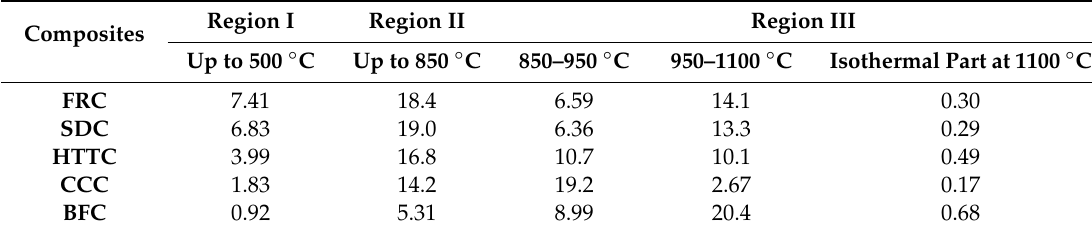
Table 7. Mass loss (wt %) of composites during TGA